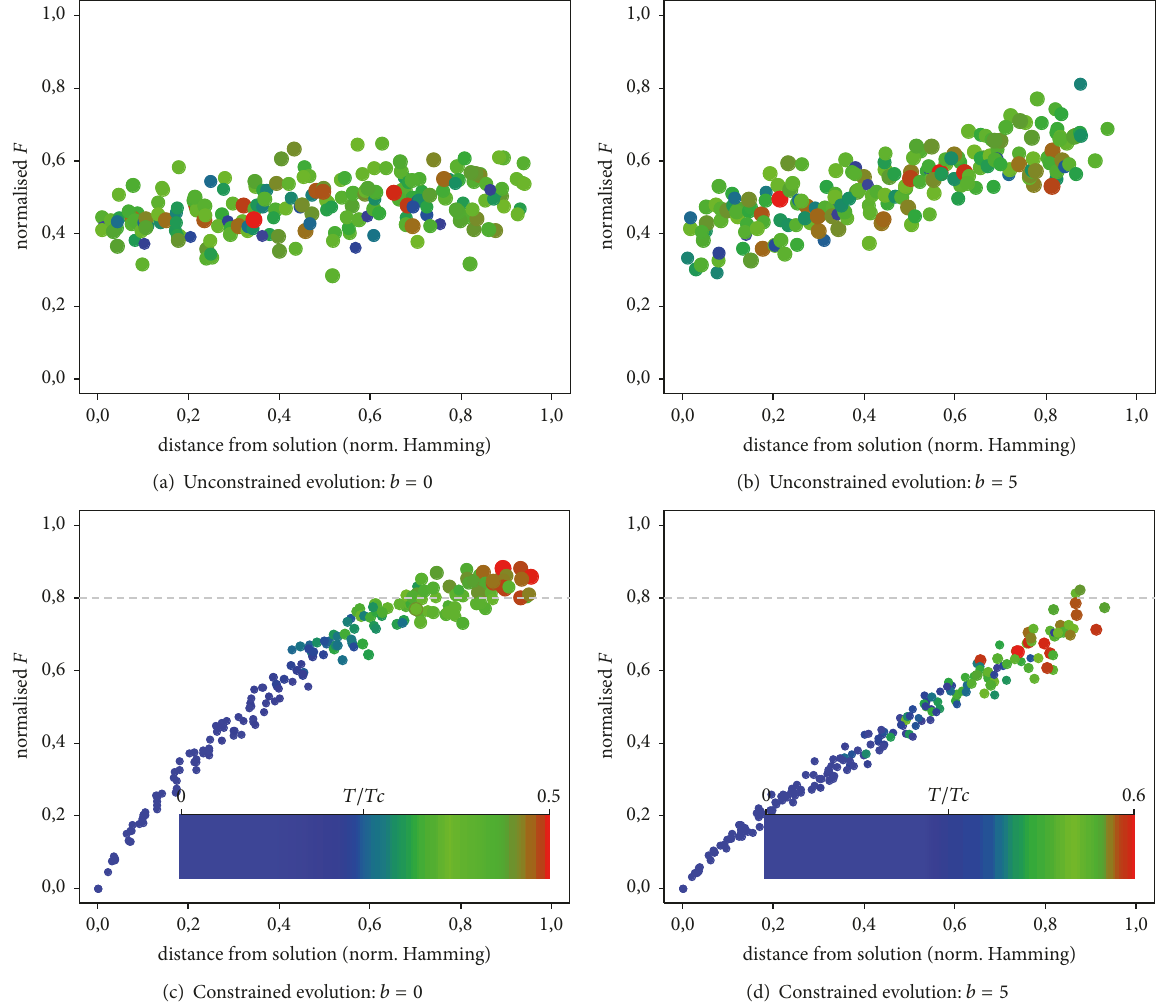
Figure 6: Constraint robustness in a self-sustainability scenario. (a, b) Unconstrained evolution. (c, d) Evolution with the CMH version. The size of the points is proportional to the temperature where the minimum value of |𝐹| is